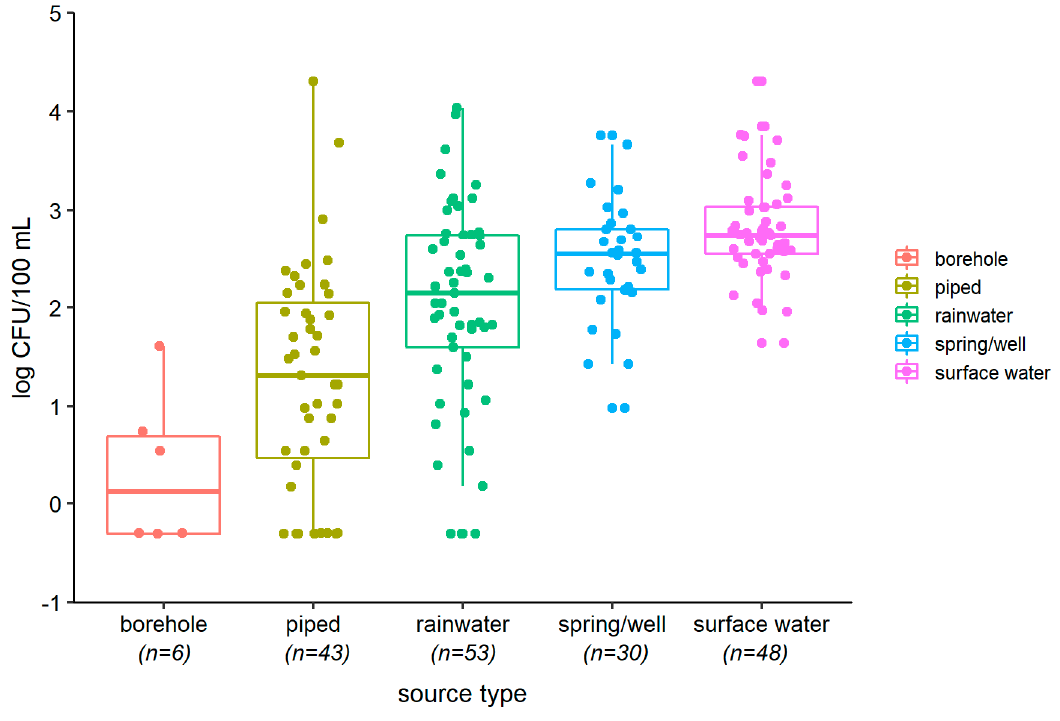
Figure 2. Boxplots showing levels (CFU / 100 mL) of intestinal enterococci by source type (superimposed dots show bacteria counts for individual samples).